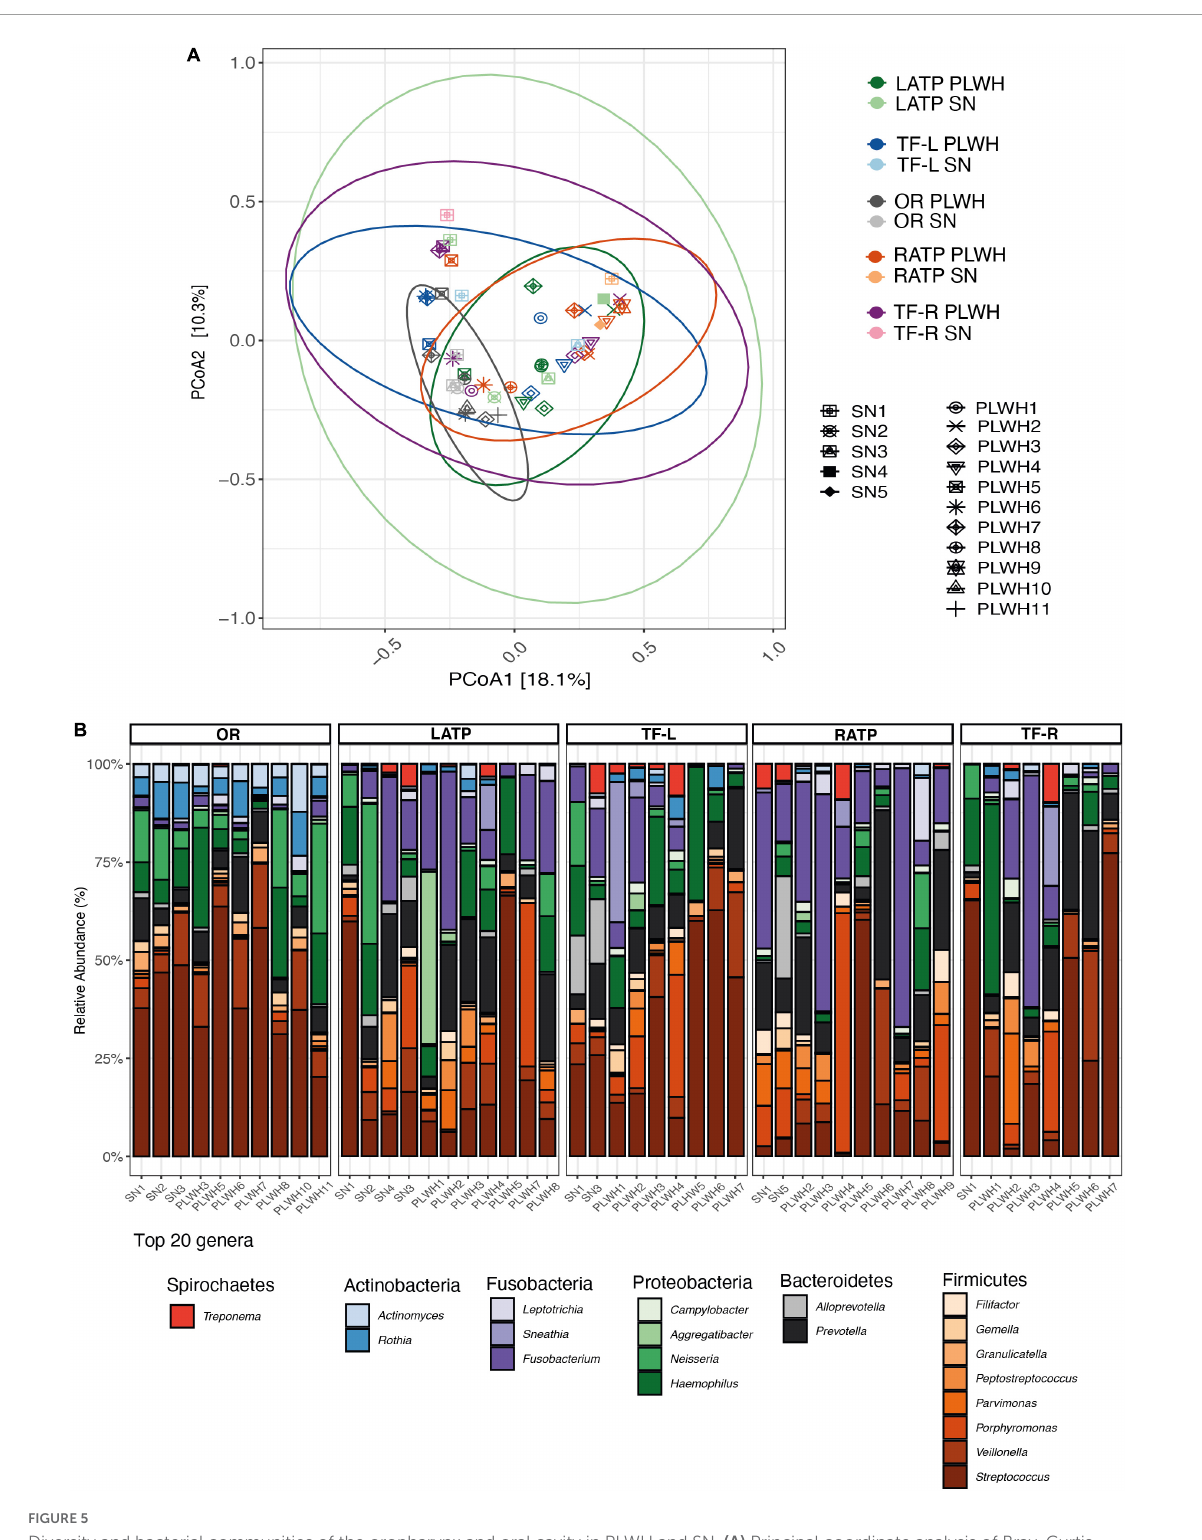
FIGURE5 Diversity and bacterial communities of the oropharynx and oral cavity in PLWH and SN. (A) Principal coordinate analysis of Bray-Curtis dissimilarity, constructed from the ASV table. Samples were clustered and painted according to their HIV status and the anatomical site. Samples did not cluster by HIV status (PERMANOVA p = 0.115). Each symbol represents a subject. Ellipses were added to visualize the bacterial communities at each anatomical site by HIV status. Two ellipses (RATP SN and TF-R SN) are missing given the low number of subjects within each group. (B) Taxa barplots showing the taxonomic composition at genus level. Only the top 20 genera are represented, these account for